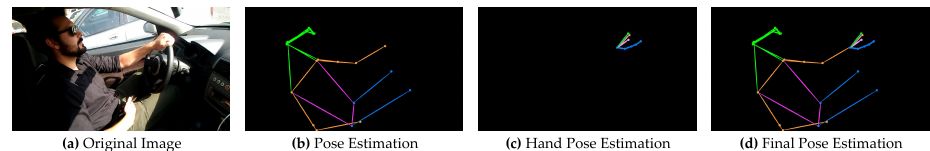
Figure 2. Body and hand pose estimation images.